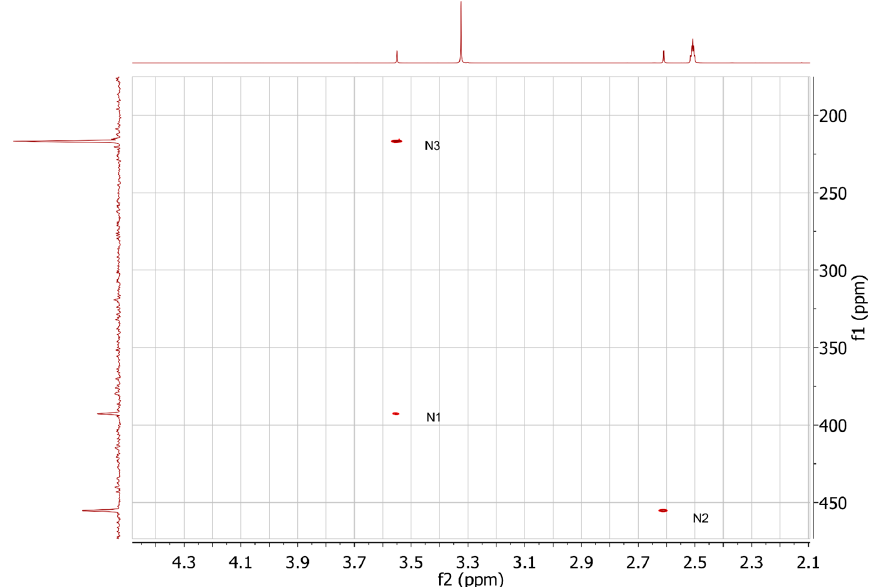
Figure 5. Heteronuclear multiple bond correlation (HMBC) experiment showing peaks corresponding to N1, N2 and N3 of the triazene chain of compound 9a .